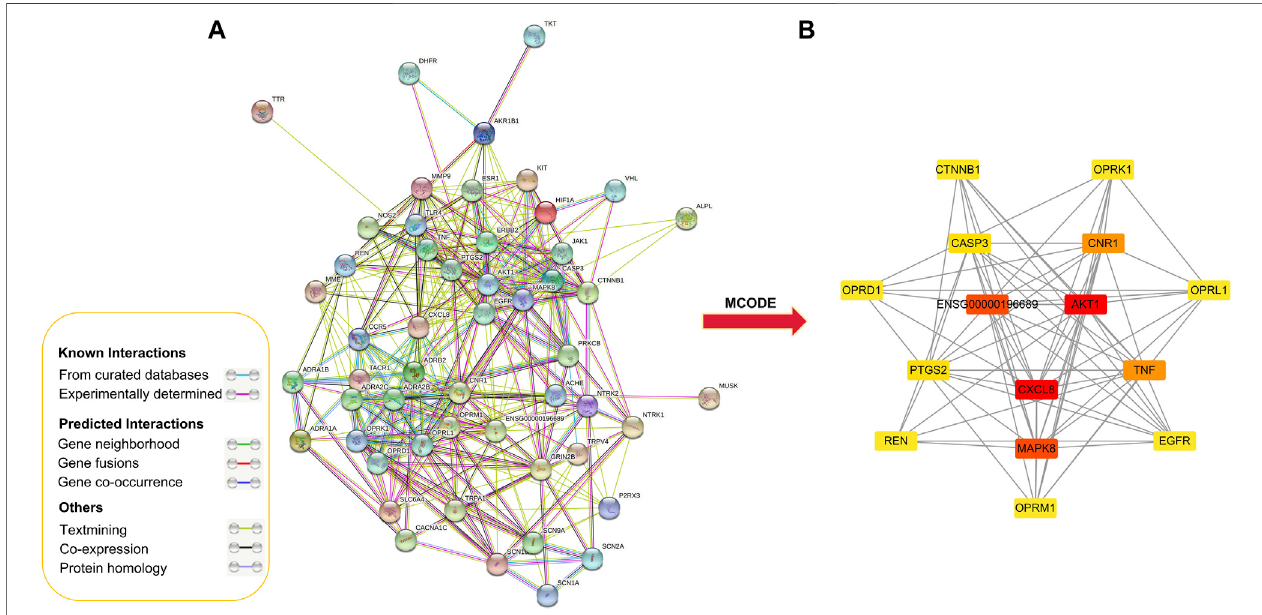
FIGURE3| Protein-proteininteractionnetworkforGEBintreatmentforNPP. (A) Protein-proteininteractionsamongthe52coretargets.Networknodesrepresent proteins, and edges represent protein-protein associations. (B) PPI network of the hub genes using MCODE plugin. The color from red/orange/yellow indicated the different importance of the nodes in the whole PPI network. That is, the redder the retangle is, the more important the node is in the PPI network.